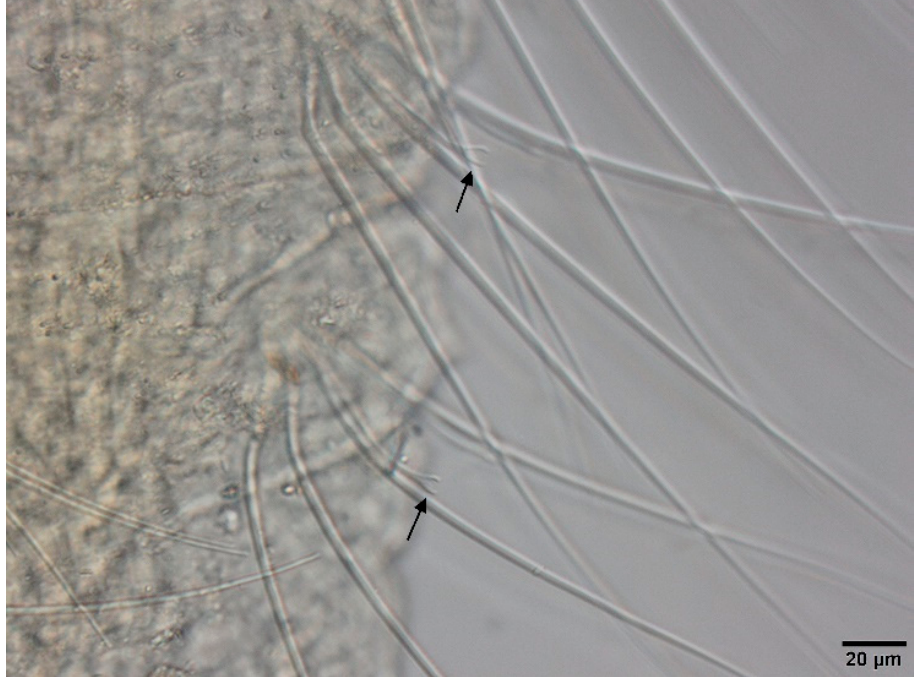
Figure 5. Anterior dorsal chaetae of Spirosperma ferox . Author: Régis Vivien.